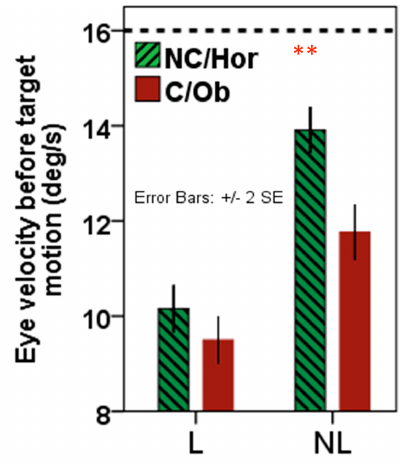
Figure 5 . Influence of anticipatory pursuit velocity on target selection? Vectorial pursuit velocities 100-90ms before collision or target motion onset per condition. The grey dotted line indicates target velocity. Bar plots indi- cate average anticipatory velocity 100-90ms before colli- sion or target motion onset per condition and target selec- tion.